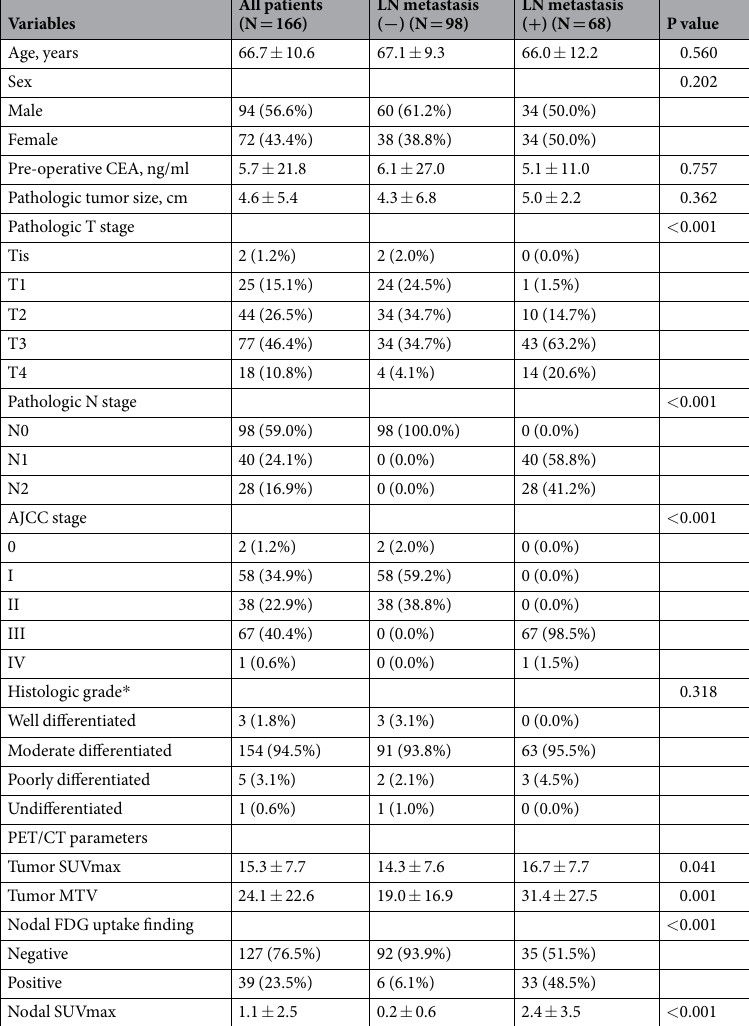
Table 1. Patient Characteristics. CEA = Carcinoembryonic Antigen; AJCC = American Joint Committee on Cancer (7th ed.); PET/CT = Positron Emission Tomography/Computed Tomography; SUVmax = maximum standardized uptake value; MTV = Metabolic Tumor Volume; * Grade cannot be assessed in three patients with mucinous